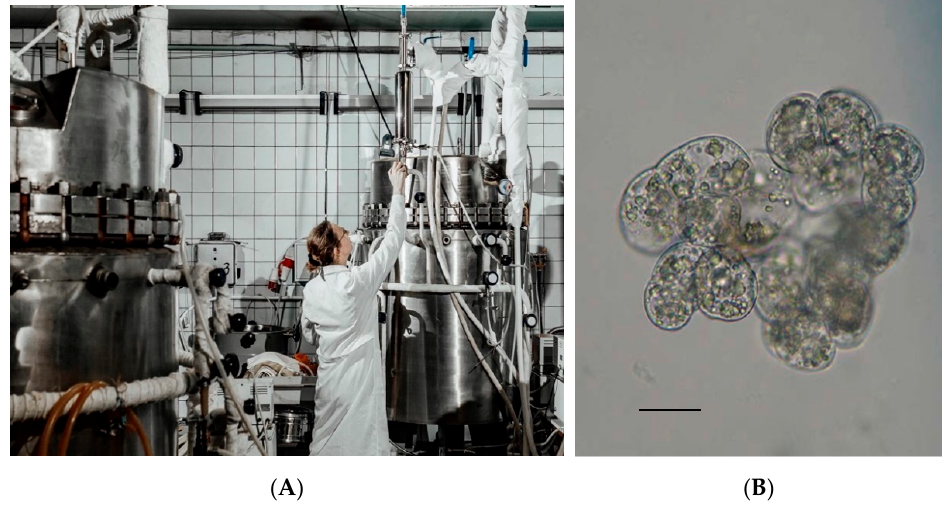
Figure 1. Bioreactor cultivation of plant cell suspensions at the Institute of Plant Physiology of Russian Academy of Sciences: ( A ) 630 L bioreactors; ( B ) Bioreactor-cultured cells of Dioscorea deltoidea at exponential growth phase (bar = 50 µm)